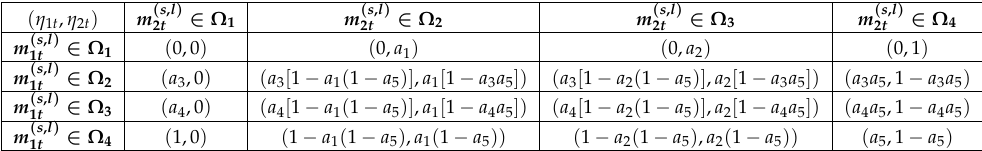
Table 3. Simplified MGMA strategy η t = ( η 1 t , η 2 t ) (cid:62) for a two-asset